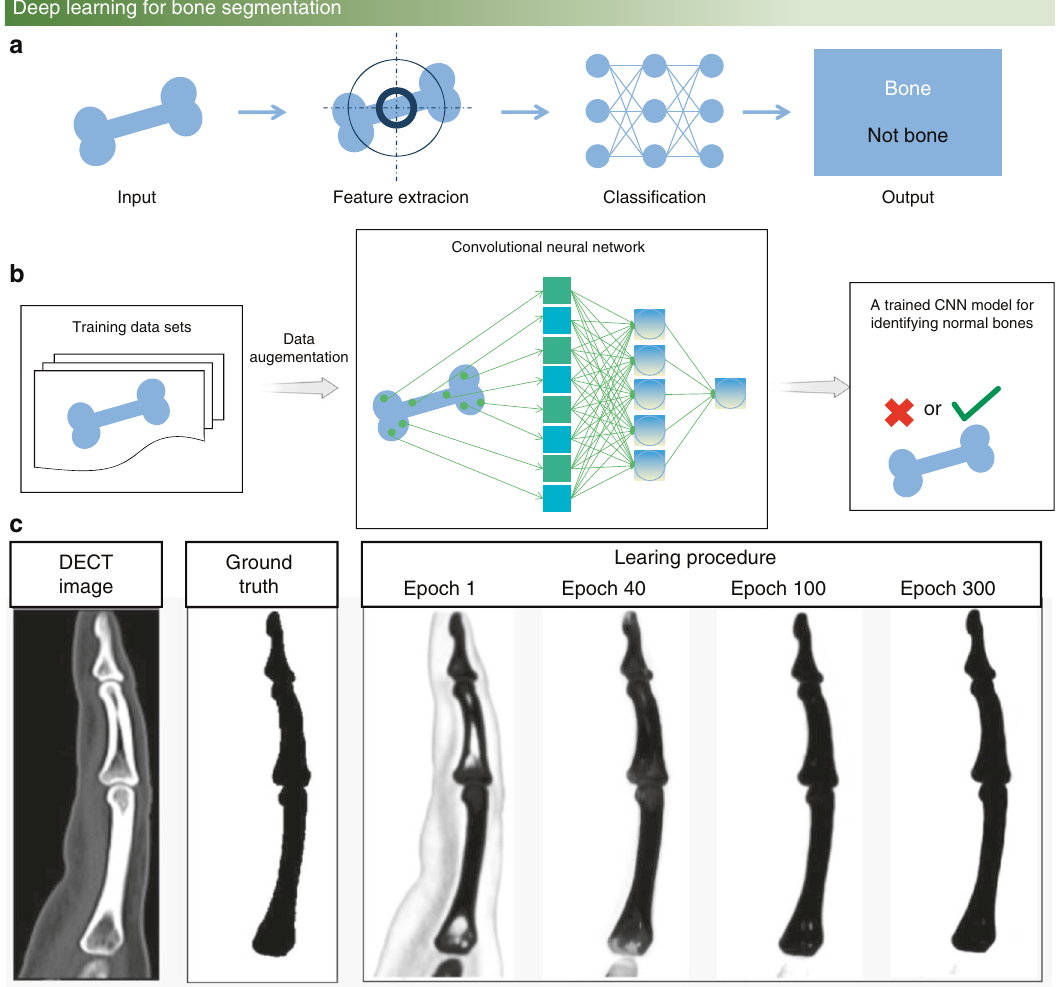
Fig. 4 Deep learning for bone research. a Overview of the machine learning process. b The process of CNN algorithm training to process images and extract features. c Optimization of the CNN algorithm for fore fi nger bone segmentation for calcinosis cutis quanti fi cation. 71 (Figures adapted with permission from Chandrasekaran et al. 71